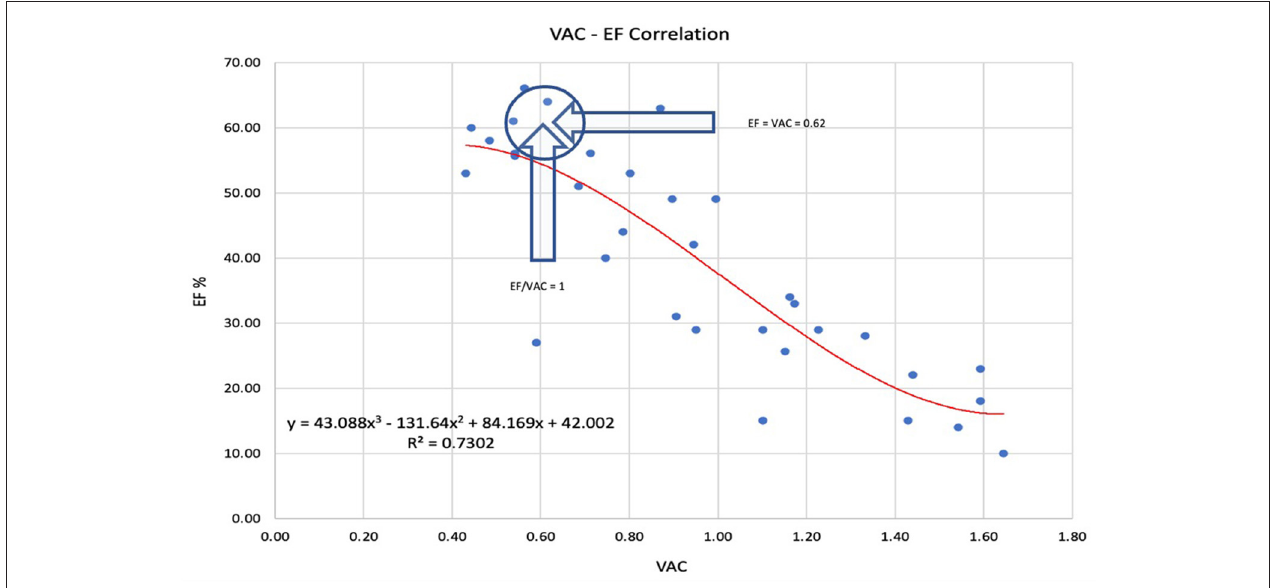
FIGURE 1 | The best prediction of the left ventricular ejection fraction (LVEF) to ventricular arterial coupling (VAC) relationship was obtained by 3rd-degree polynomial regression. The arrows indicate the point where LVEF